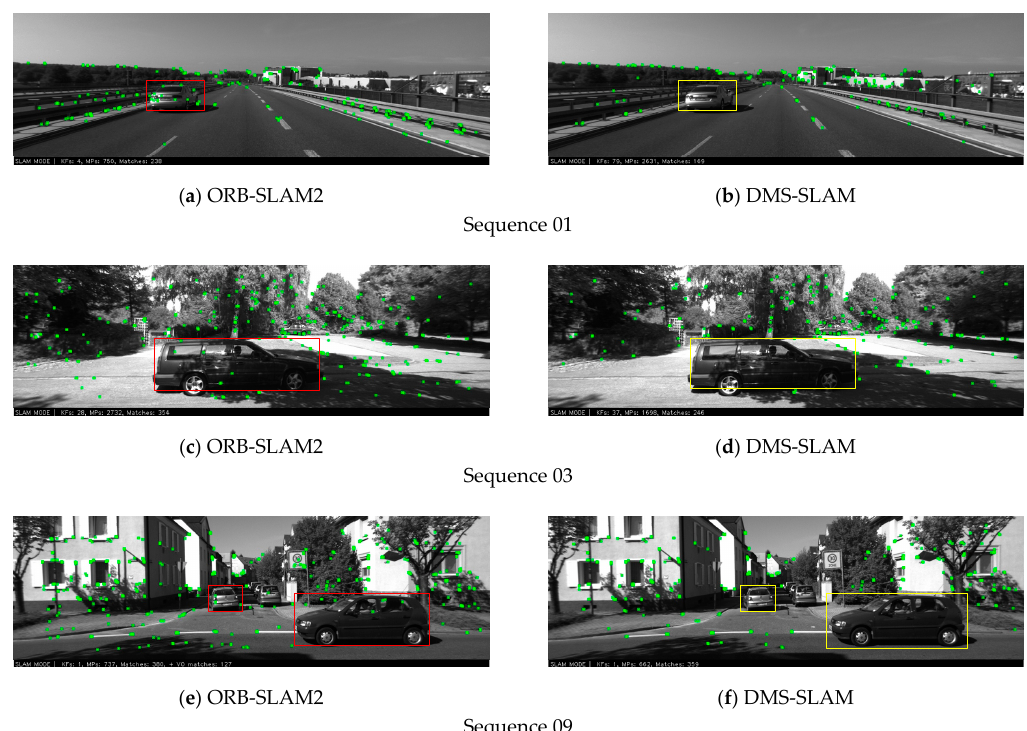
Figure 15. The pose tracking experiments of ORB-SLAM2 and DMS-SLAM on the 01, 03, 09 sequences in the KITTI dataset. The rectangular box represents the moving object in the scene, and the others are static areas. Table 4. Positioning accuracy and tracking time of stereo vision SLAM on KITTI